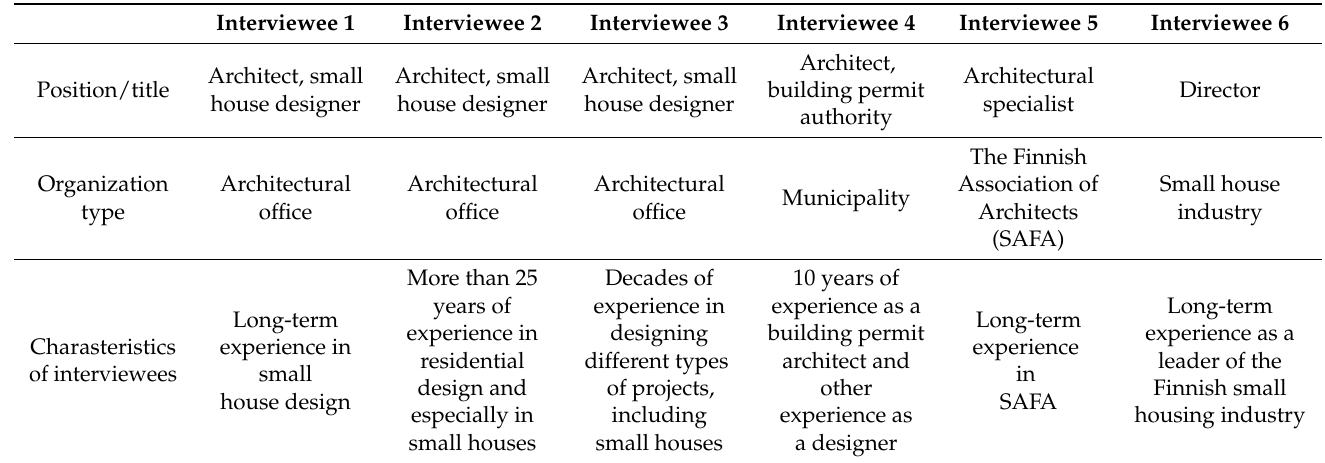
Table 1. Interviewees by their position/title, and organization